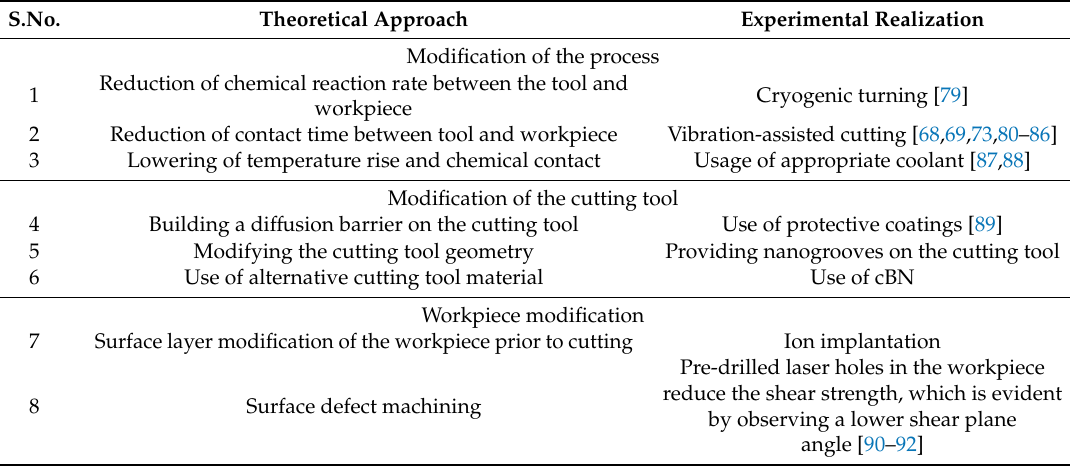
Table 2. Modified form of measures suggested for improved machinability [37].